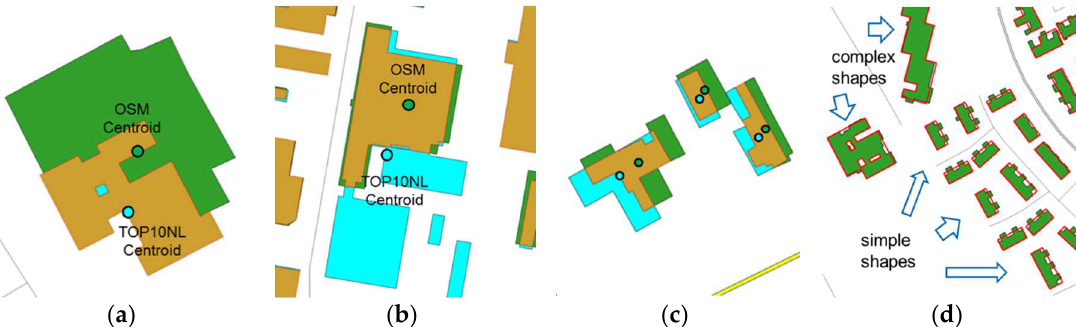
Figure 4. ( a , b ) Situations where complex shapes should not be aligned by their centroids, ( c ) with a known exception where offset causes A - B and B - A being comparable in size; ( d ) determination of simple vs. complex shapes by looking into their simplified shapes (the red outlines are simplified OSM buildings; see text for explanation).